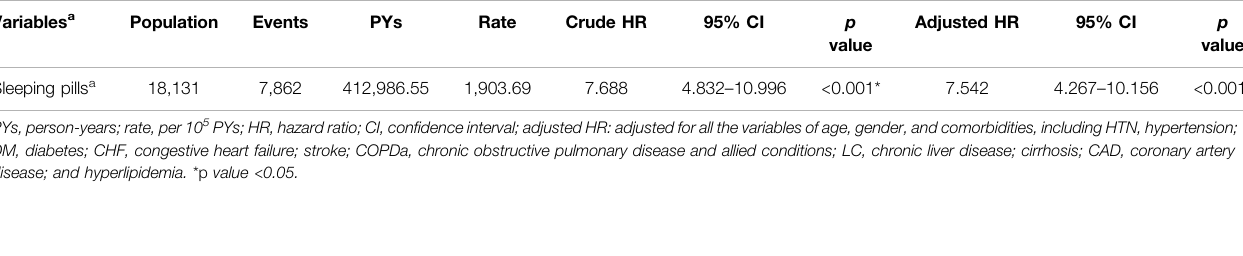
TABLE 3 | Factors of ESRD among CKD patients by using Cox regression.